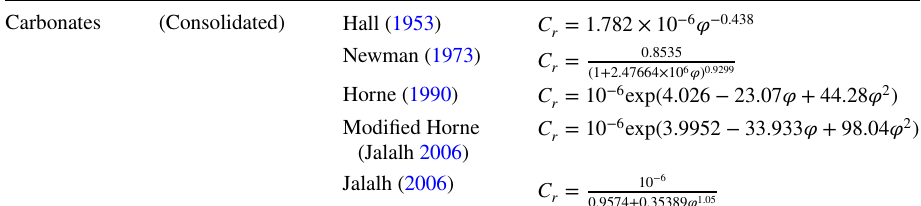
Table 1 Industry correlations of rock compressibility, C p (in 1/psi) for carbonates. The unit of the estimated rock compressibility ( C p ) values by the correlations is